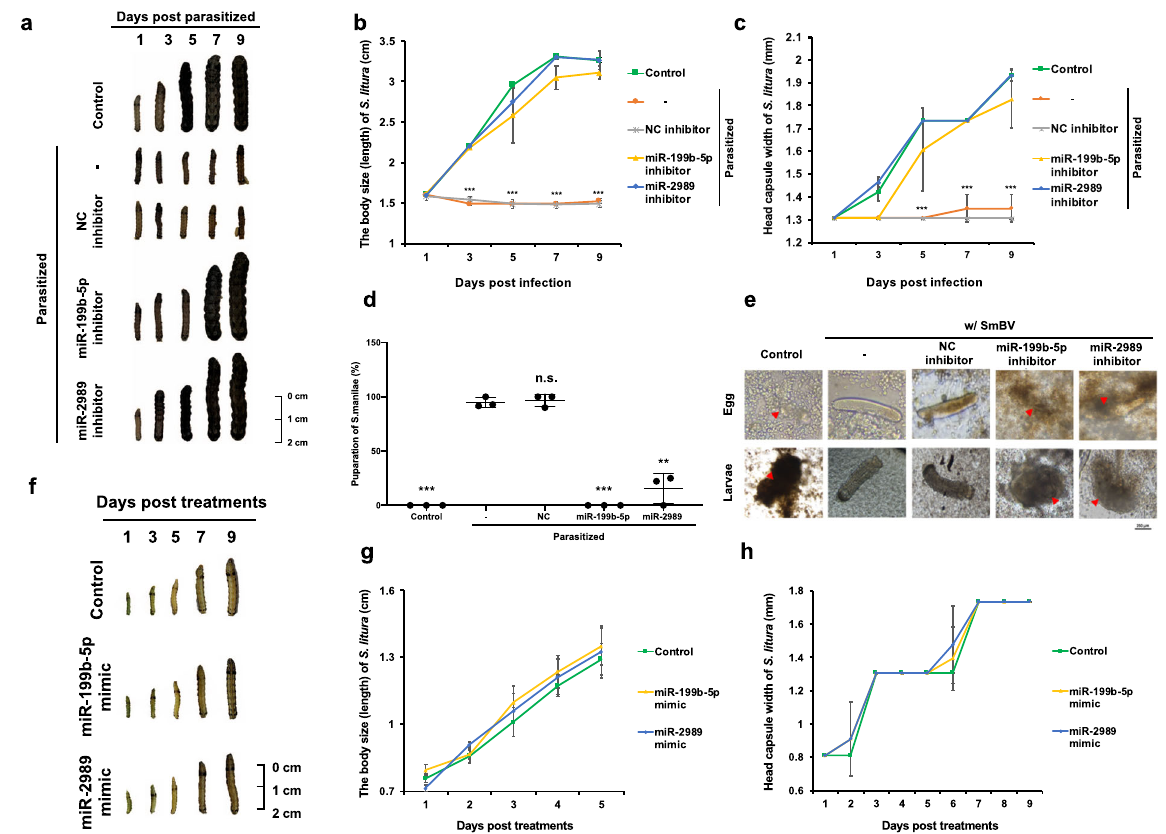
inhibitors before parasitism by S. manilae wasps for 48 h. Arrow: S. manilae . The developments of S. litura larvae were measured by their b body sizes (lengths) and c head capsule width after parasitism (Control: unparasitized S. litura ) (Green square: Control, orange circle: Parasitized, gray